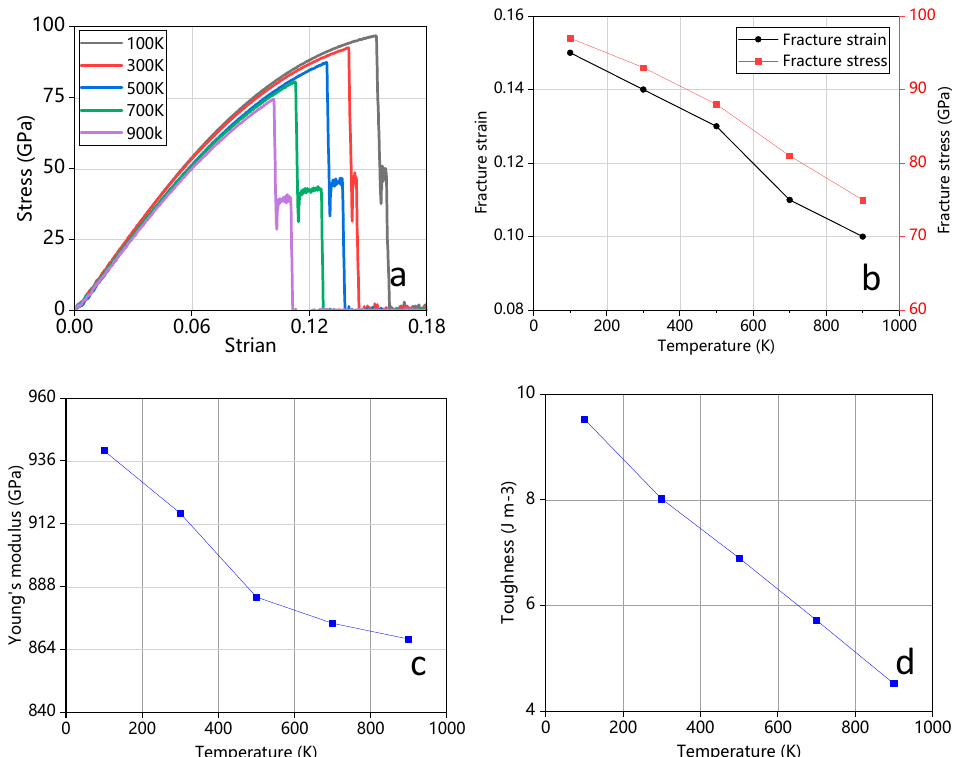
Figure 3. Mechanical properties of bilayer graphene with increasing temperature. ( a ) Stress–strain relationships, ( b ) fracture strain and fracture stress, ( c ) Young’s modulus, and ( d ) fracture tough- ness. Both the linear elastic part and the nonlinear part of the mechanics properties decayed with increasing temperature.